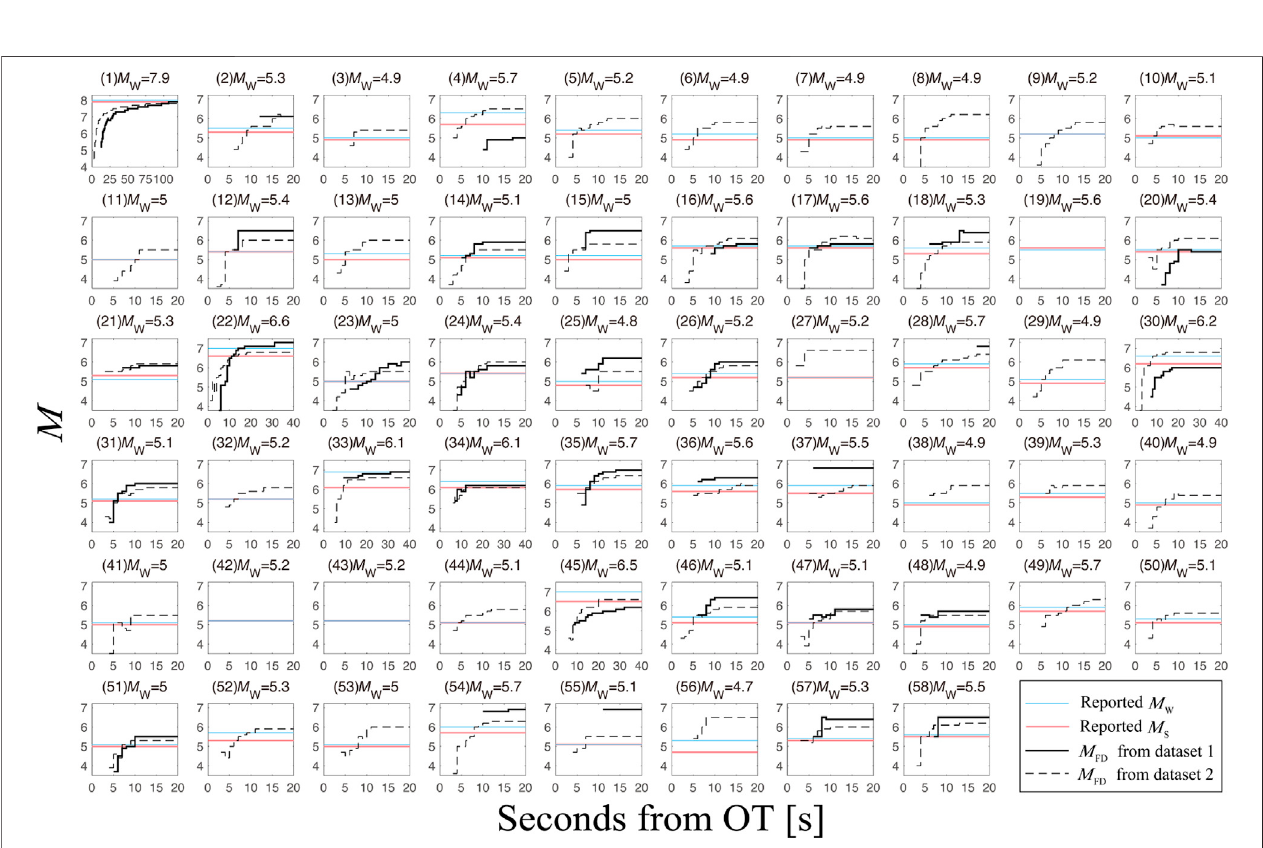
FIGURE 9 | Temporal evolution of FinDer magnitude, M FD , from event origin time (OT) for all 58 earthquakes (neglecting data latencies).